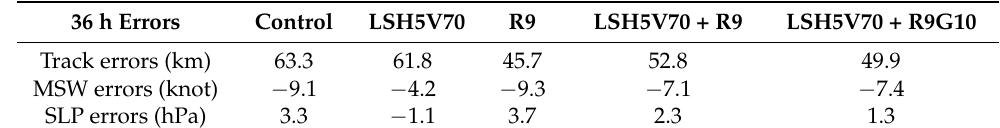
Table 5. The mean 36 h forecast errors from lidar wind speed and/or radar data and combined data assimilation with different gross errors of radar radial wind.